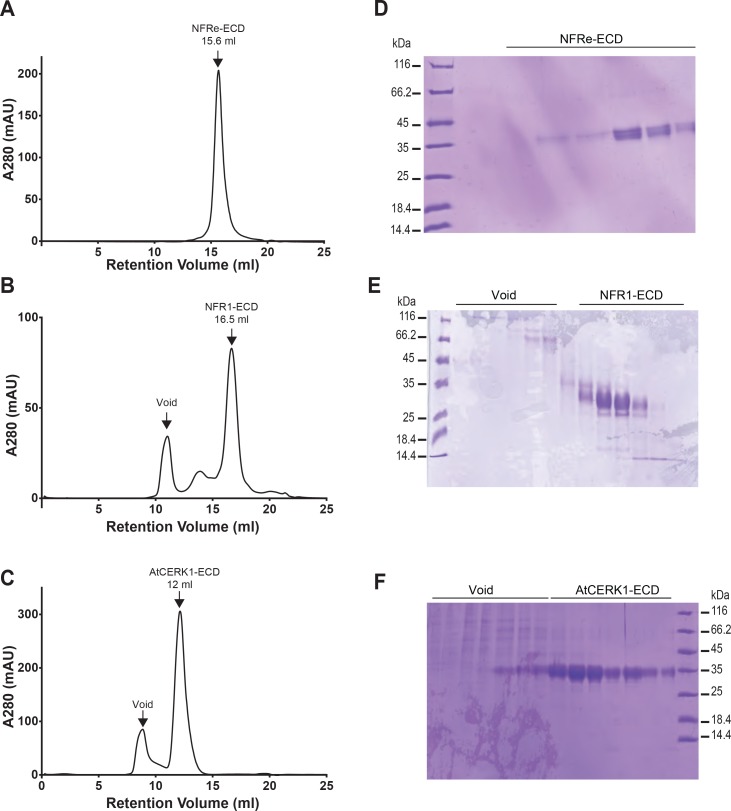
Purification of NFRe, NFR1 and AtCERK1 ectodomains.Size exclusion chromatography profiles of glycosylated NFRe (A) and NFR1 (B) ectodomains purified on a Superdex 200 10/300 GL column. SEC profile of glycosylated AtCERK1 ectodomain purified on a Superdex 75 10/300 GL column (C). In the SEC profiles, glycosylated NFRe, NFR1 and AtCERK1 ectodomains elutes as single monodisperse peaks. (D, E, F) Corresponding SDS–PAGE analysis of the SEC runs. Glycosylated NFRe has two glycosylation states as visible by the two bands around 35 kDa (D), whereas glycosylated NFR1 appears as three diffused glycosylation states ranging from 27 to 35 kDa (E). Glycosylated AtCERK1 is visible as a diffuse band around 35 kDa (F).